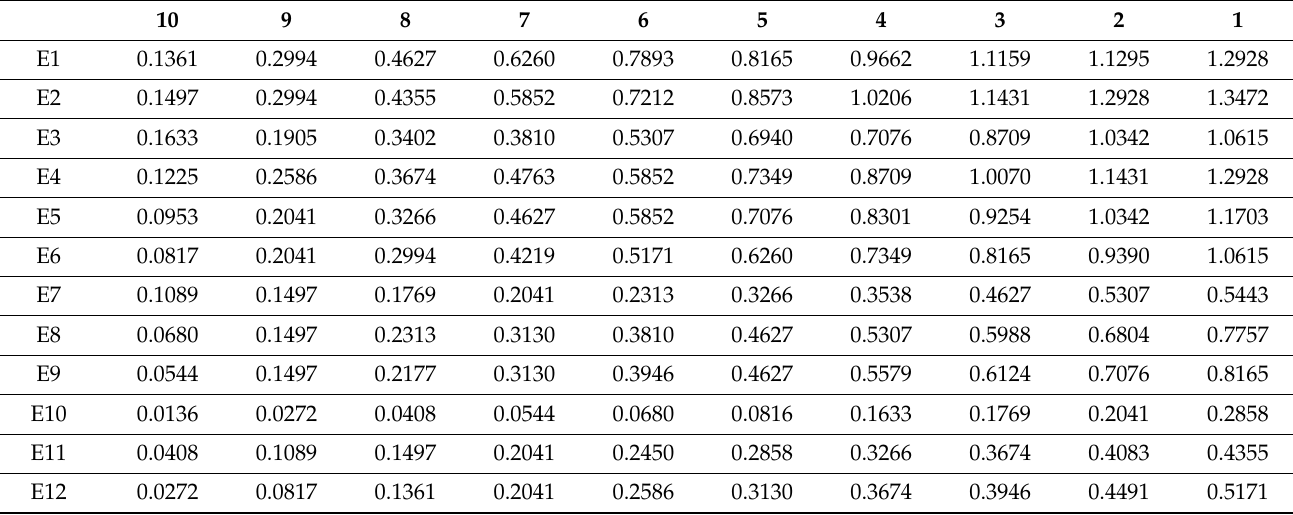
Table 5. Accumulative matrix.